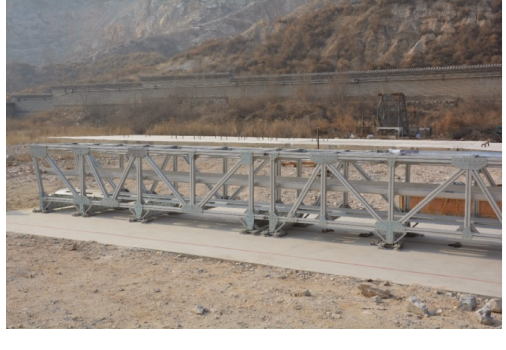
Figure 5: Ground ejection test. Table 1: Missile ’ s o ff track speed simulation and test results. Project